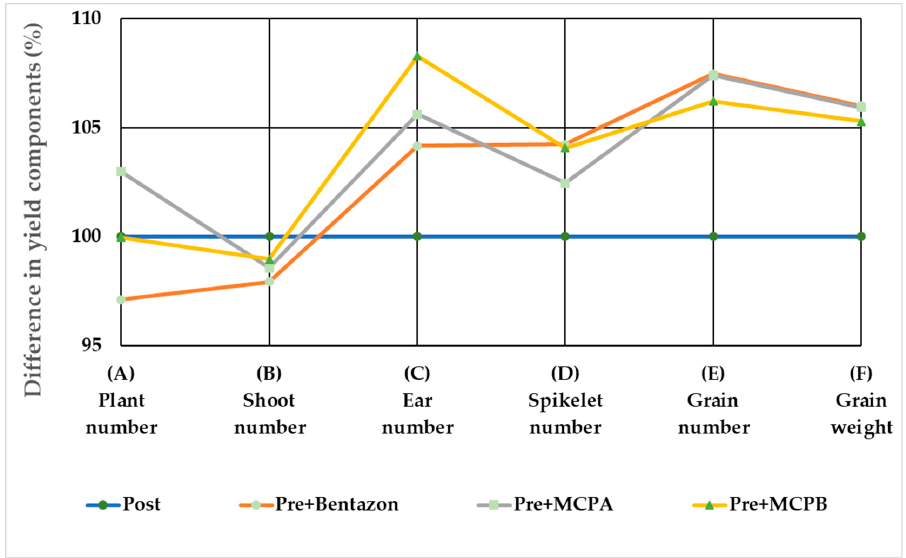
Figure 5. The effect of pre-emergence treatments on the development of winter wheat ( Triticum aestivum L.) in post-emergence treatments at stem elongation, over an average of 2 years.